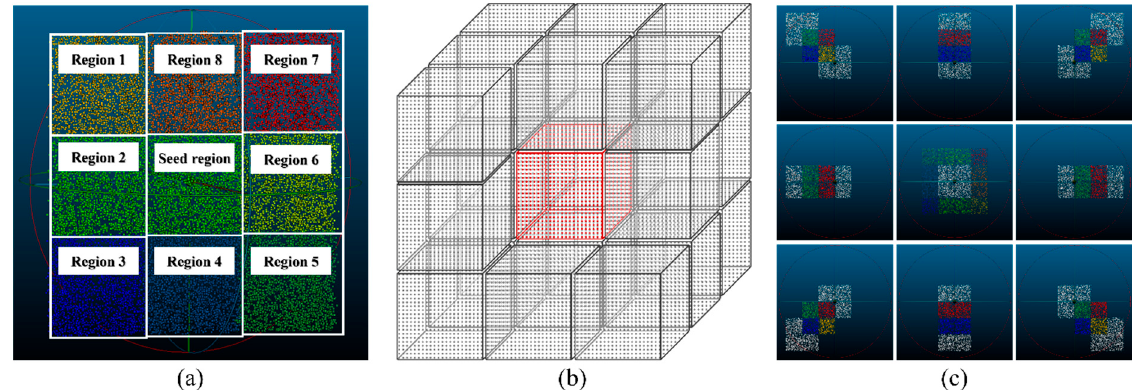
Figure 10. ( a ) Points in regions; ( b ) Seed region colored by red and adjacent regions colored by grey; ( c ) Process of connectivity checking.